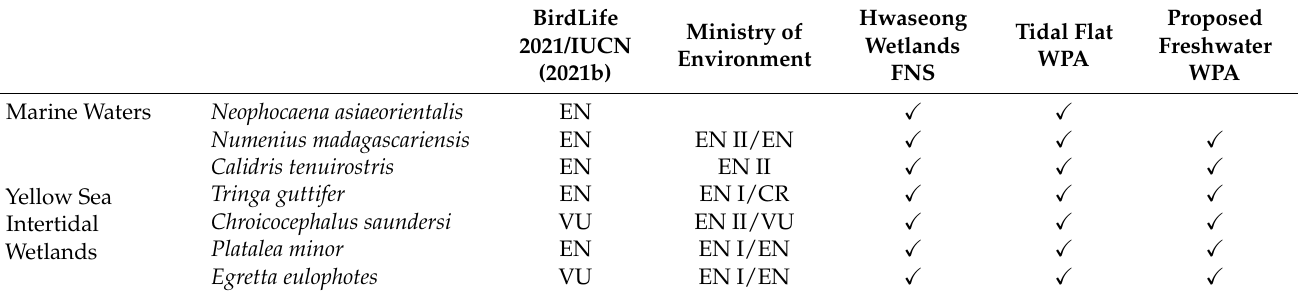
Table 3. Presence (“ (cid:88) ”) of globally threatened marine and wetland species observed during the main surveys in the FNS as a whole, in the Tidal Flat WPA, and in the Proposed Freshwater WPA